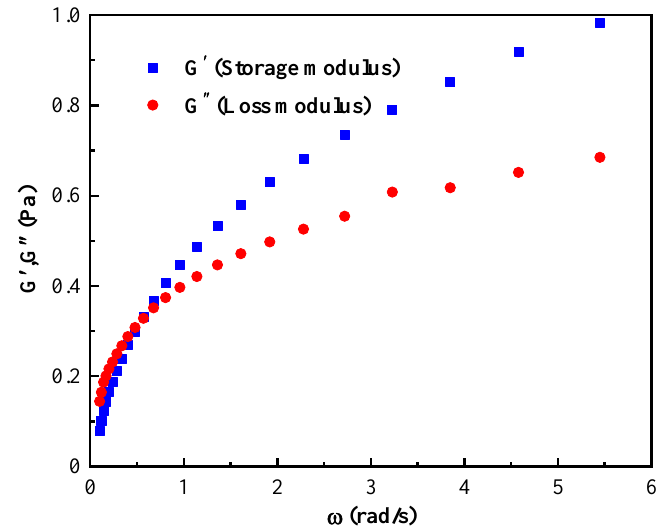
Figure 5. Viscoelastic modulus of PAAm solution as a function of frequency.